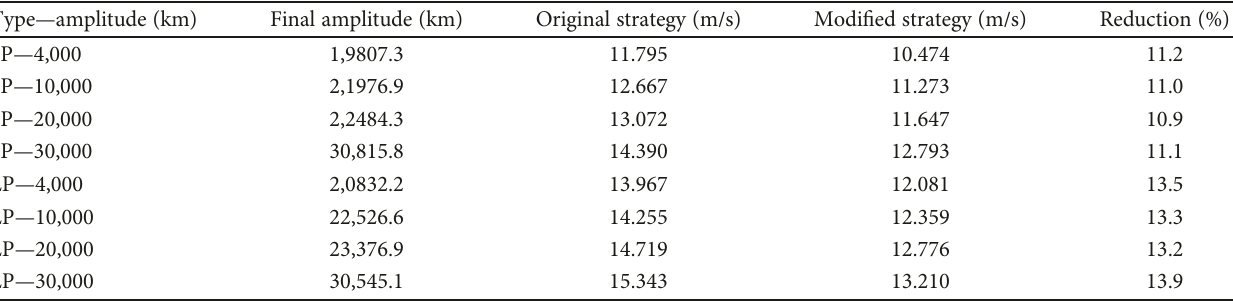
Table 7: Station-keeping results of LPOs around L